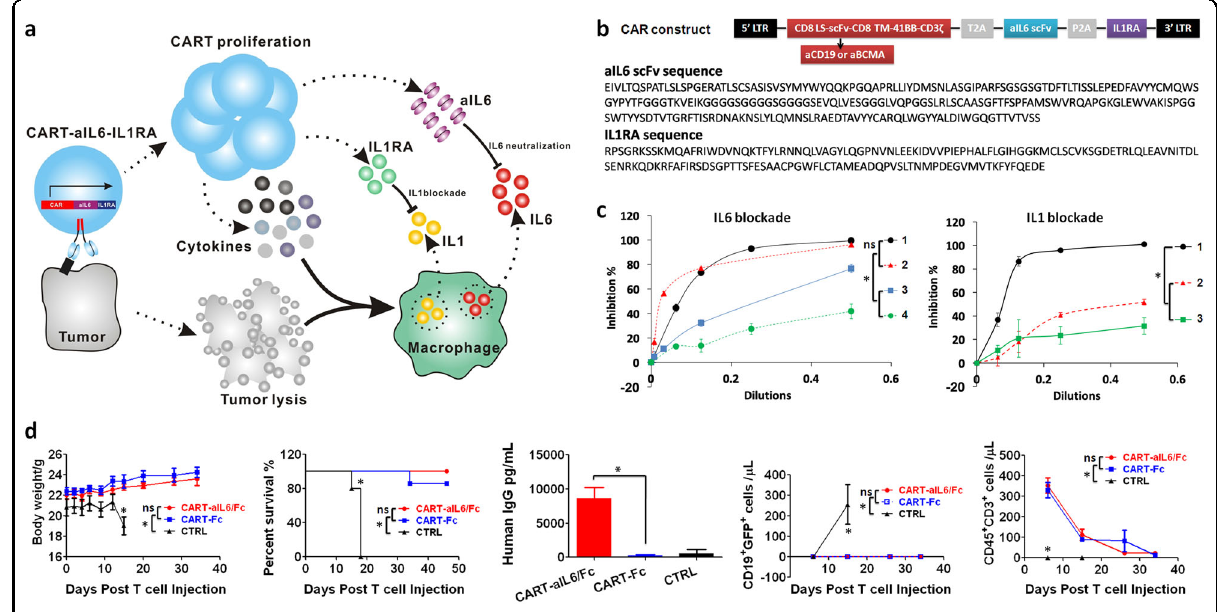
Fig. 1 Design of CART for secreting IL6 and IL1 antagonists. a The schematic illustration of CART-secreted anti-IL6 scFv and IL1RA in blocking IL6 and IL1 signalings during CRS of CART therapy. b The design of CAR construct and the sequences of aIL6 scFv and IL1RA. c Comparison of gene delivered expression of different scFv targeting IL6 or IL6R in blocking IL6 signaling and the scFv was consisting of variable regions derived from 1- Sarilumab, 2-Sirukumab, 3-Siltuximab or 4-Tocilizumab. Optimization of co-expressing IL1RA with aIL6 for inhibiting IL1 signaling. Construct 1 includes, from N-terminus to C-terminus, T2A linker, scFv derived from Sirukumab, P2A linker, and IL-1RA (T2A-Sir-P2A-IL1RA). Construct 2 contains, from N-terminus to C-terminus, T2A linker, scFv antibody, (G4S)3 linker, and IL1RA (T2A-Sir-(G4S)3-IL1RA). Construct 3 contains, from N-terminus to C- terminus, scFv antibody, (G4S)3 linker, IL1RA, and T2A linker (Sir-(G4S)3-IL1RA-T2A). Triplicate was included in the test. d Anti-tumor ef fi cacy of anti- CD19 CART-aIL6/Fc ( n = 8) and CART-Fc ( n = 7) in Xenograft model and quanti fi cation of CART-secreted aIL6/Fc in D6 serum. The representative results of two independent experiments were presented. Student ’ s t -test was conducted, and * denotes statistical signi fi cance of P < 0.05. ns means no signi fi